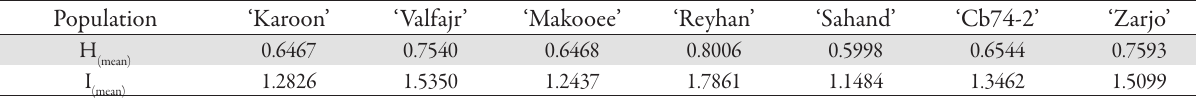
Tab. 3. Shannon information index and heterozygosity values of barley cultivars